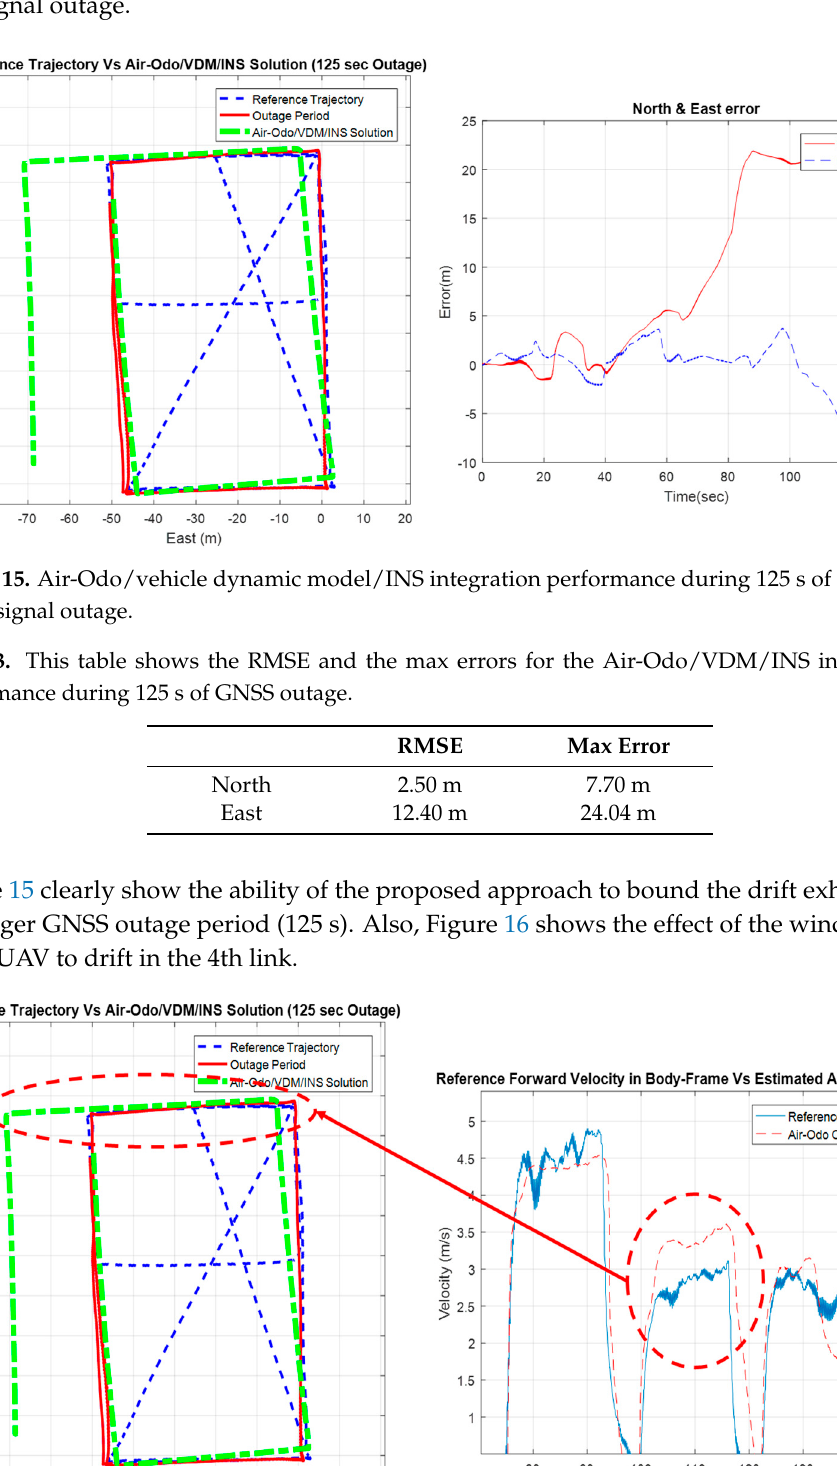
Figure 16. Effect of wind gust on Air-Odo/vehicle dynamic model/INS integration and navigational performance.